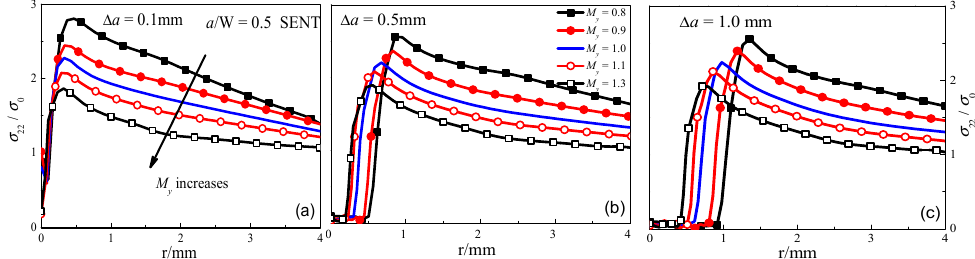
Figure 8. Crack tip opening stress distributions ahead of current crack tip, a / W = 0.5, ( a ) ∆ a = 0.1 mm; ( b ) ∆ a = 0.5 mm; ( c ) ∆ a = 1.0 mm.